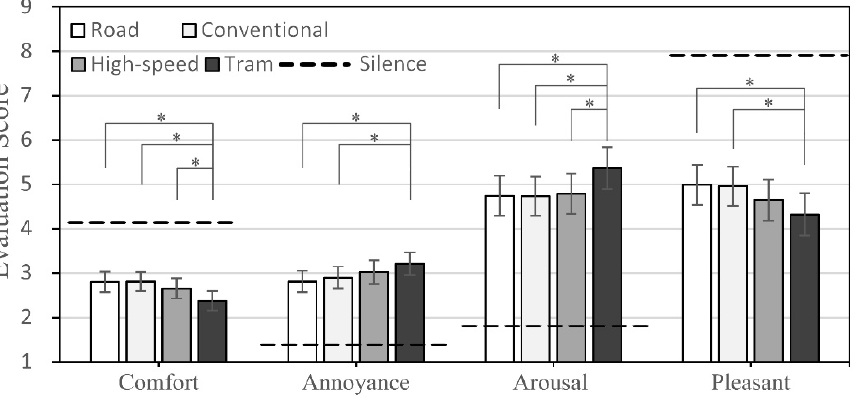
Figure 5. Effect of sound type on psychological attributes. The vertical bars represent 95% confidence intervals. * represents significant differences in pair-wise comparison (LSD) at 0.05 level.